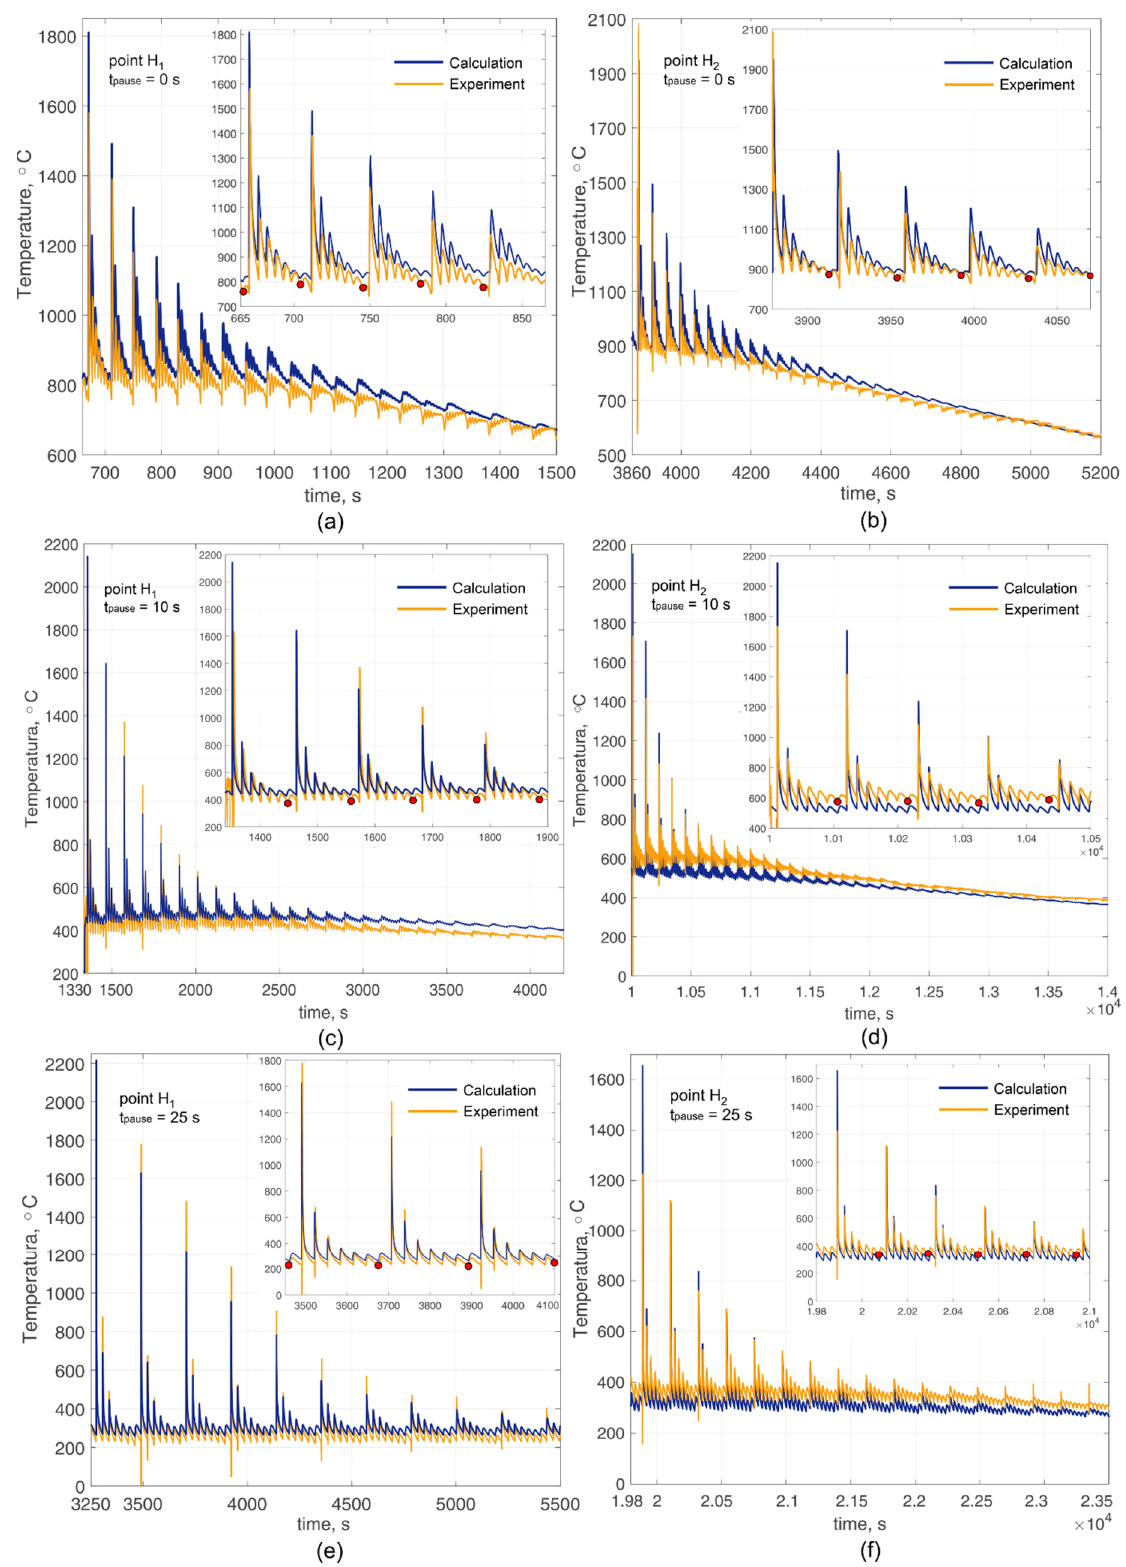
Figure 8. Comparison of calculated and experimental thermal cycles during deposition of the multi-track wall: ( a ) point H 1 , pause time is 0 s; ( b ) point H 2 , pause time is 0 s; ( c ) point H 1 , pause time is 10 s; ( d ) point H 2 , pause time is 10 s; ( e ) point H 1 , pause time is 25 s; ( f ) point H 2 , pause time is 25 s.